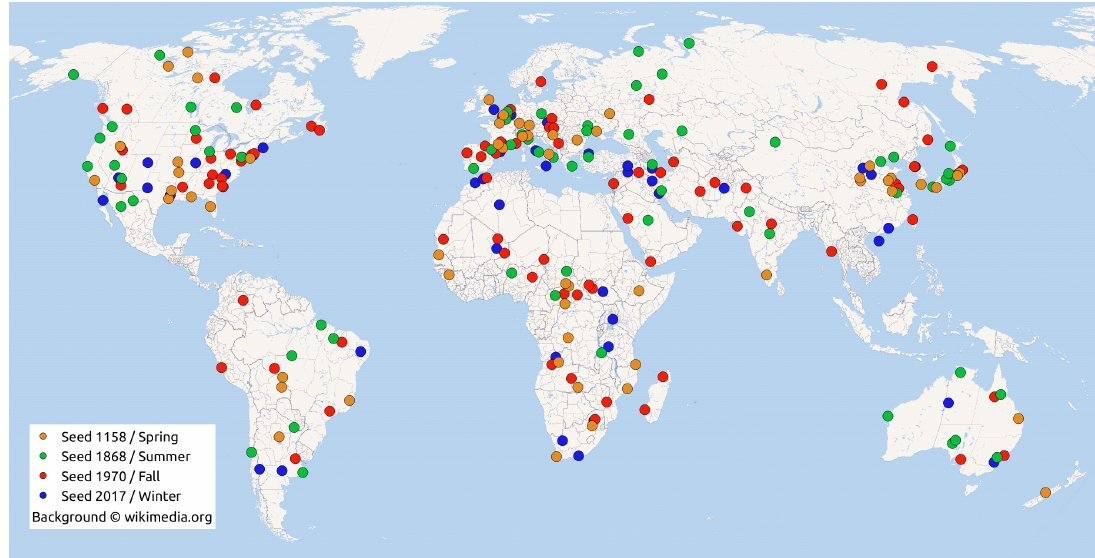
Figure 3. Final distribution of the ROIs over all inhabited land masses of the Earth.